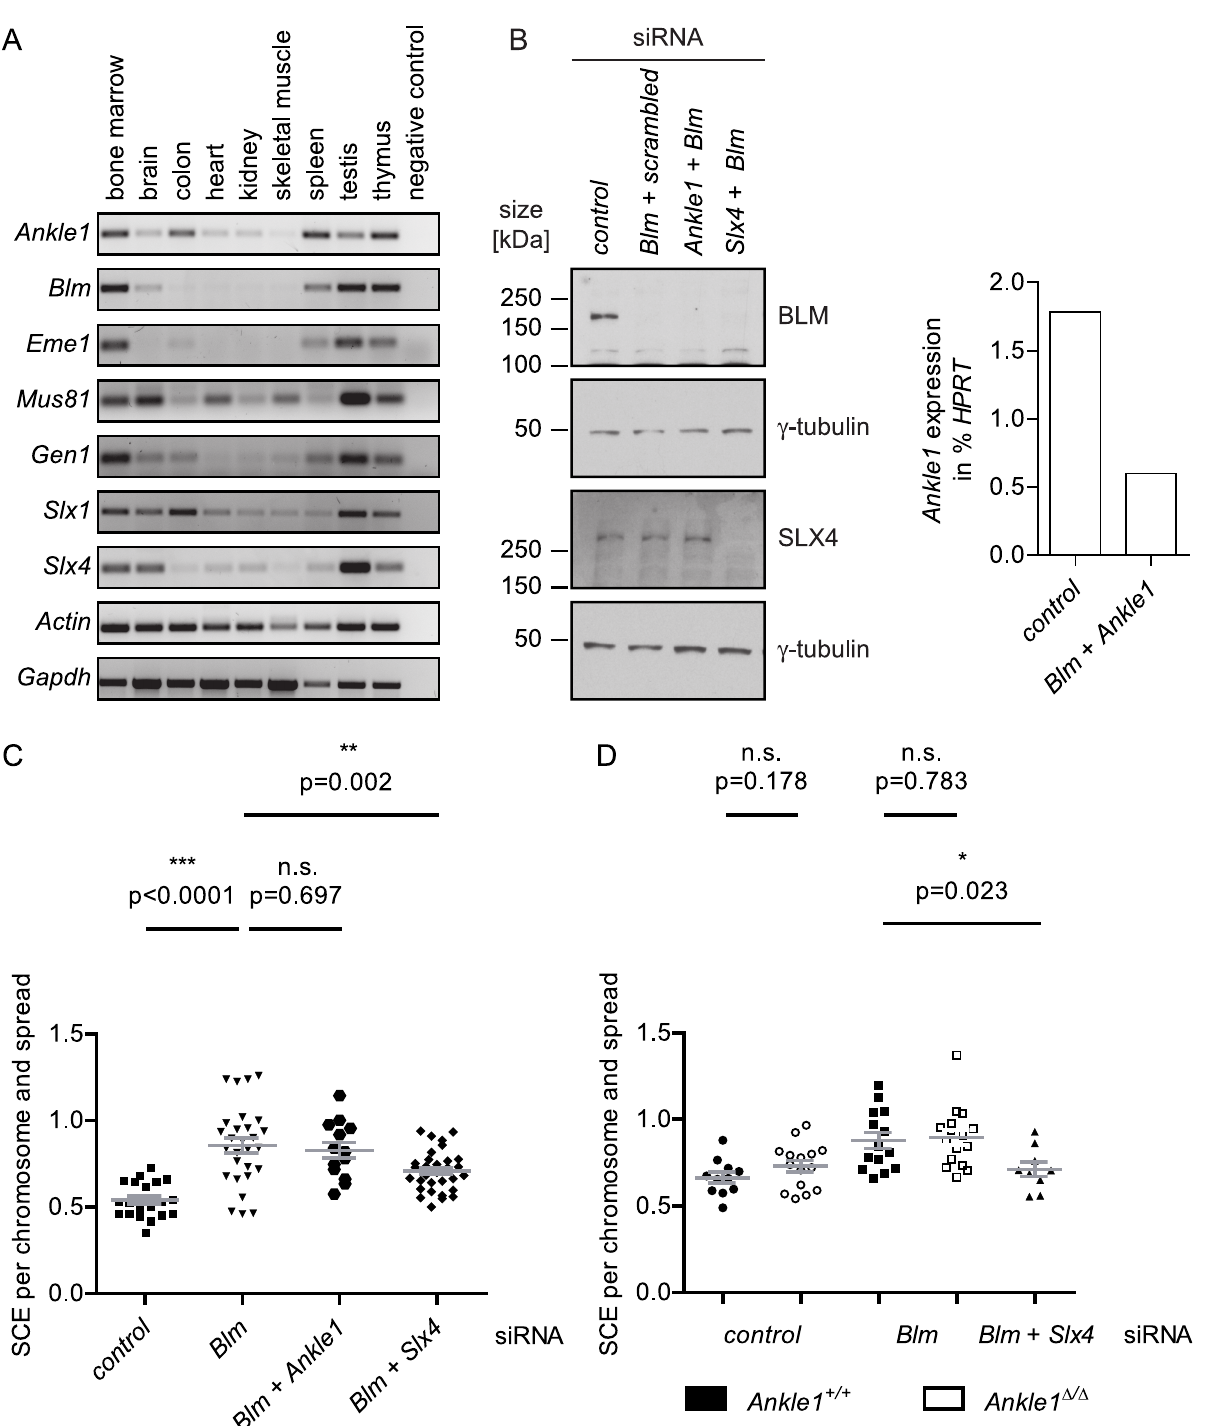
Fig 7. Involvement of ANKLE1 in Holliday junction resolution. (A) mRNA expression profile of Ankle1 and known proteins involved in Holliday junction resolution after double strand break repair in somatic cells, representative end point PCR, Actin and Gapdh serve as loading control; (B) Western blot and qPCR analysis of iMEFs 48 h after transfection with indicated siRNAs; Scatter plot of sister chromatid exchange (SCE) frequencies in (C) Wild-type iMEFs and (D) Wild-type vs. Ankle1 Δ / Δ iMEFs following siRNA treatment, each dot represents one metaphase spread, horizontal bars represent the mean, error bars: standard error of the mean, p values were determined using the students t test, n.s. not significant, * significant (p (cid:1) 0.05), ** very significant (p (cid:1) 0.01), *** extremely significant (p (cid:1) 0.001).